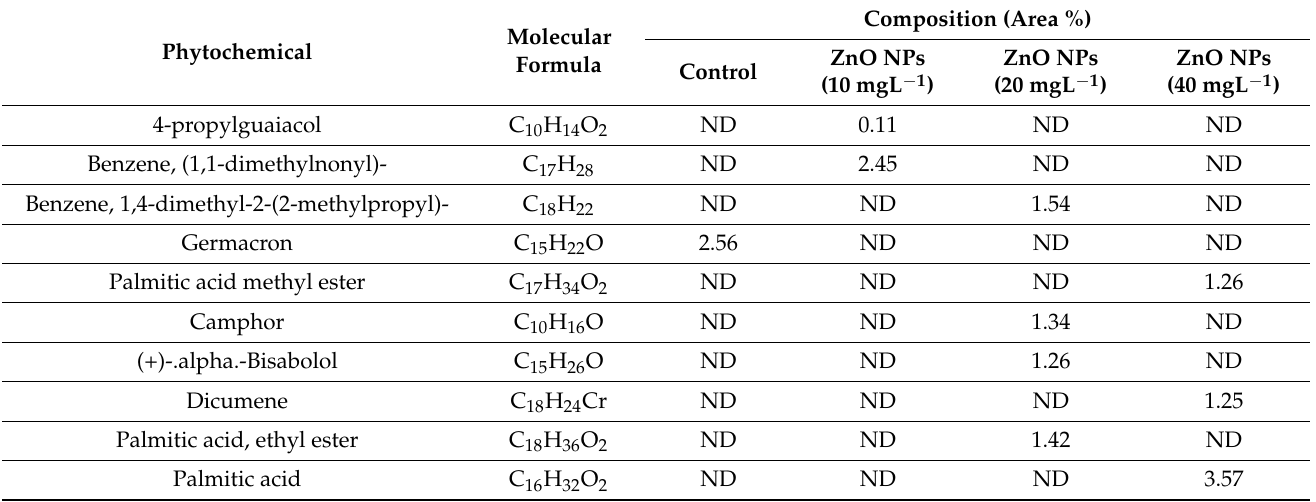
Table 8. Comparison of the compositions of compounds detected only in some but not all of the ethanolic rhizome extracts from C. longa plants of various experimental groups. Ethanolic extracts from three plants were measured to obtain the average value as presented. ND: not